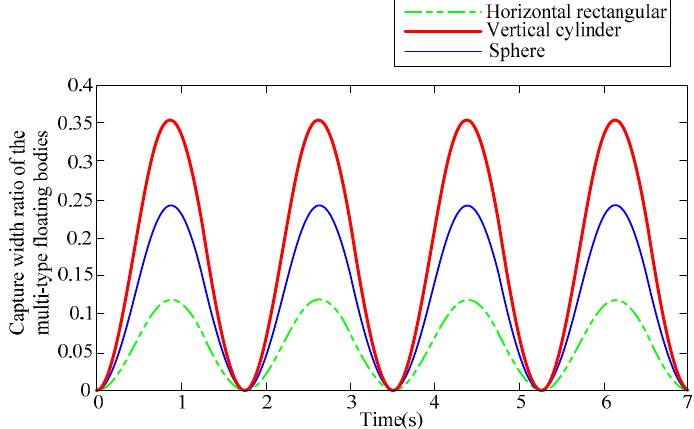
Figure 6. The heaving displacement of the multi-type floating bodies ( H = 0.3 m, T = 3.5 s).